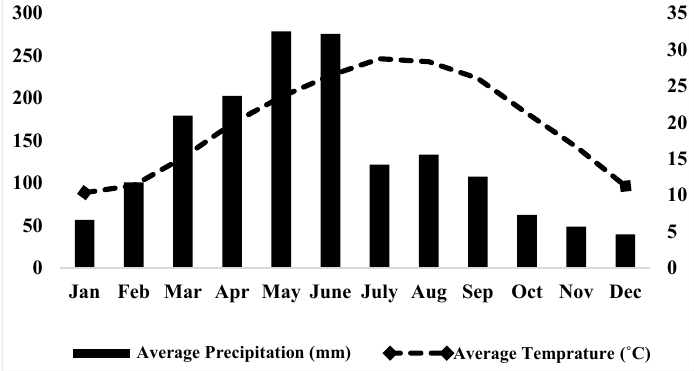
Figure 2. Average monthly precipitation and temperature of the study area in 2017.